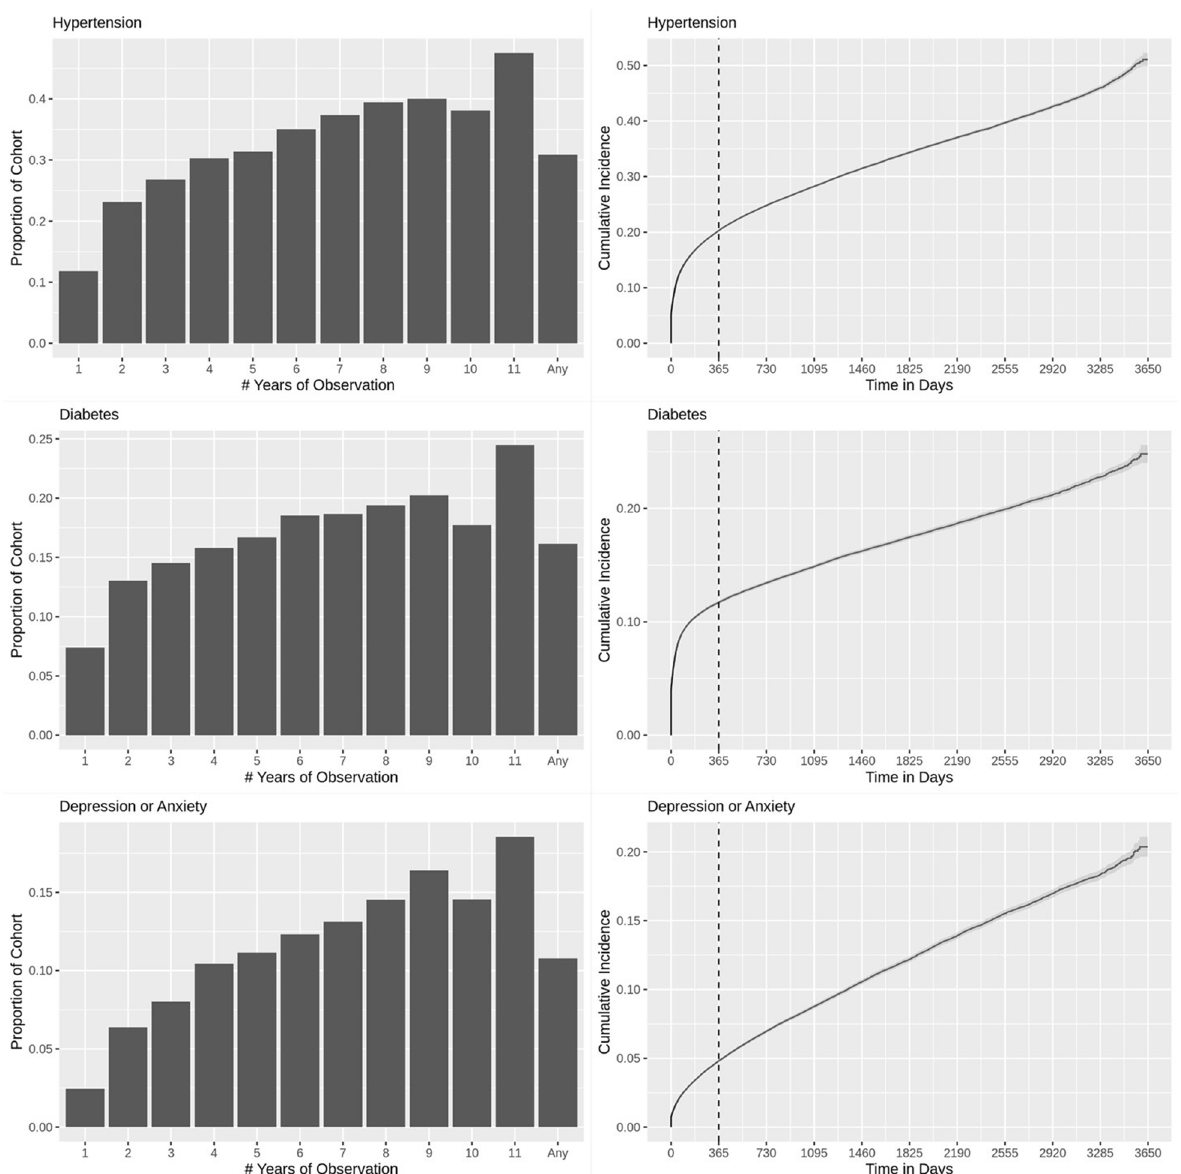
Figure 1: Example observation-based period prevalence and cumulative incidence plots